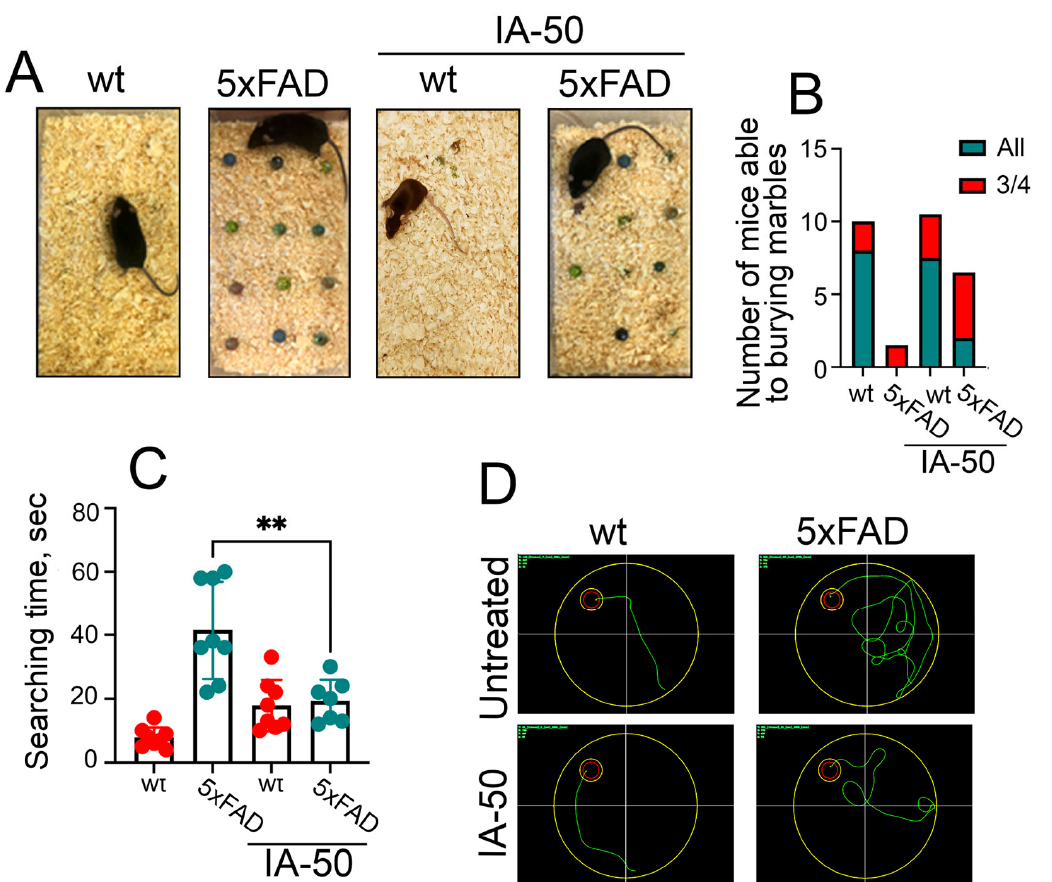
Figure 4. Behavioural tests of the 5xFAD mice after therapy with IA-50 . ( A ) Marble Burying Assay results in the 5xFAD mice treated with IA-50 at P360. An illustration of the Marble Burying Assay method. The left panel shows a healthy mouse that buried all the marbles; on the second panel a 5xFAD mouse presented that did not receive treatment; and the last two panels demonstrate wt mouse treated with IA-50 that also buried almost all marbles and 5xFAD mouse that received IA-50 treatment and buried several balls at a given time. ( B ) Test results. The blue bars show the number of animals that buried all the proposed balls, the red bars show the number of mice that buried ¾ of all the balls. ( C ) Results of the Morris water maze assay performed at P450. The time necessary to find the platform on the 6th day after the start of training is shown. ** p < 0.01 . ( D ) Representative tracks of the wt and 5xFAD mice treated with IA-50 . The tracks are in green; the platform itself is in red.